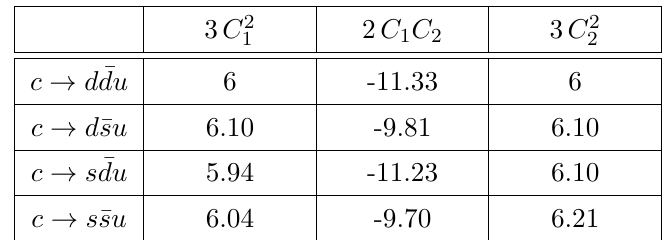
for ρ = 0 . 006 and µ D ,nm